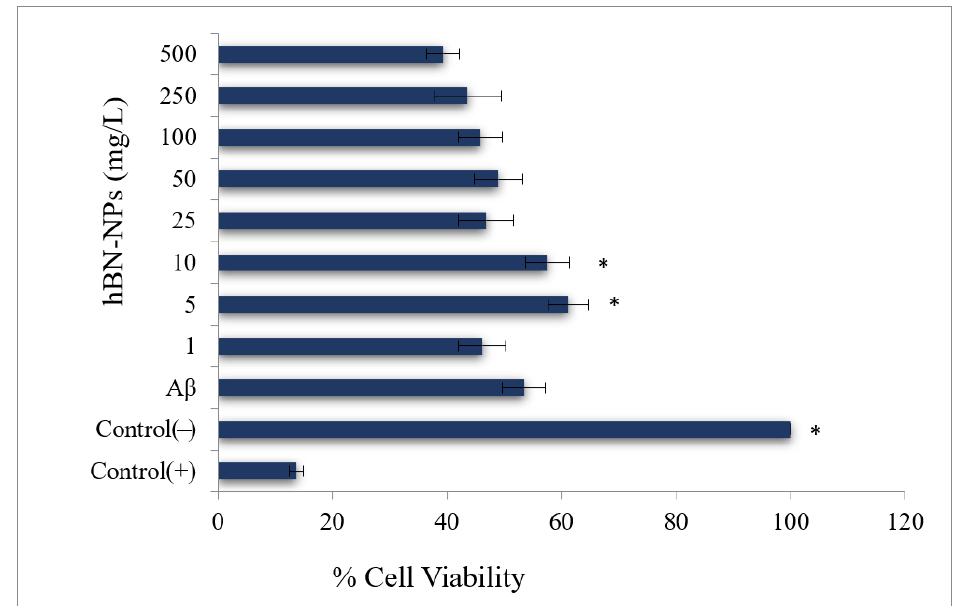
Figure 7. Effects of hBN-NPs on A β toxicity in cultured differentiated human SH-SY5Y cells as measured by mitochondrial activity (MTT assay). (Control ( − ): Cells without hBN-NPs; Control (+): Cell treated with Triton-X. * Symbol presents significant differences at the p < 0.05 level from the A β group).